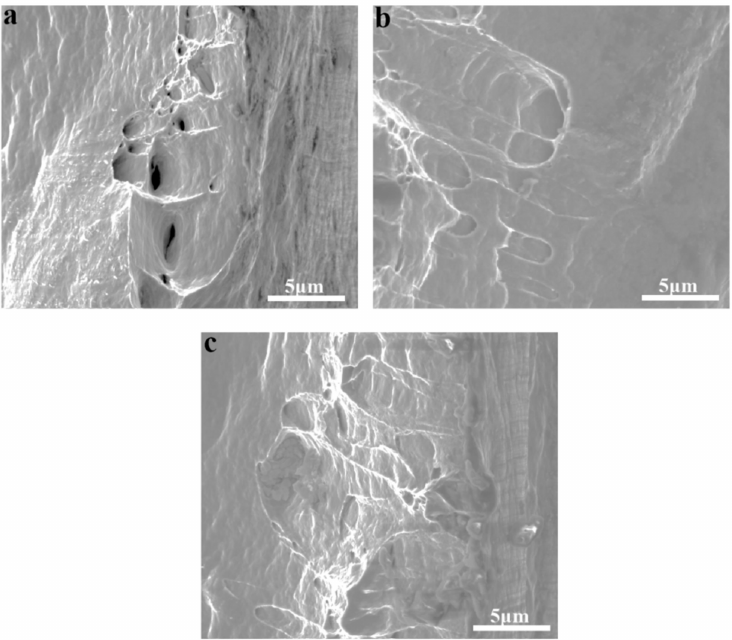
Figure 3. Fracture surface of the Al–xFe–0.1Si–0.07La alloys: ( a ) Al–0.07Fe–0.1Si–0.07La; ( b ) Al–0.2Fe– 0.1Si–0.07La; and ( c ) Al–0.4 Fe–0.1Si–0.07La.